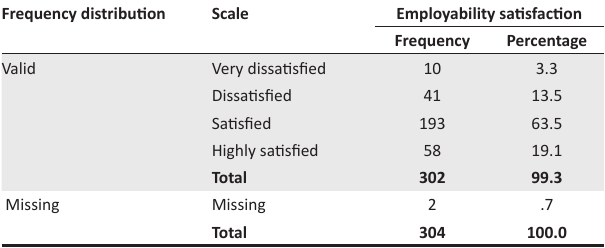
TABLE 3: Frequency distribution – employability